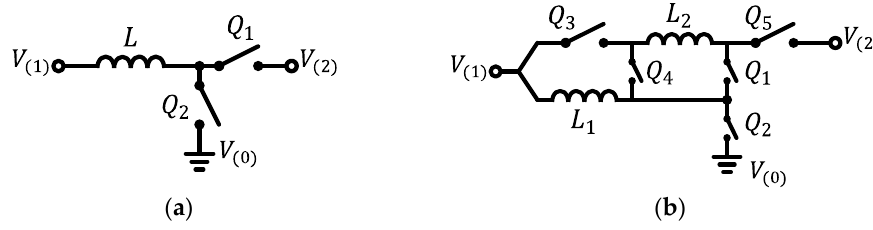
Figure 15. ( a ) Simplified diagram of a HB topology. ( b ) Simplified diagram of a MSIBC topology.